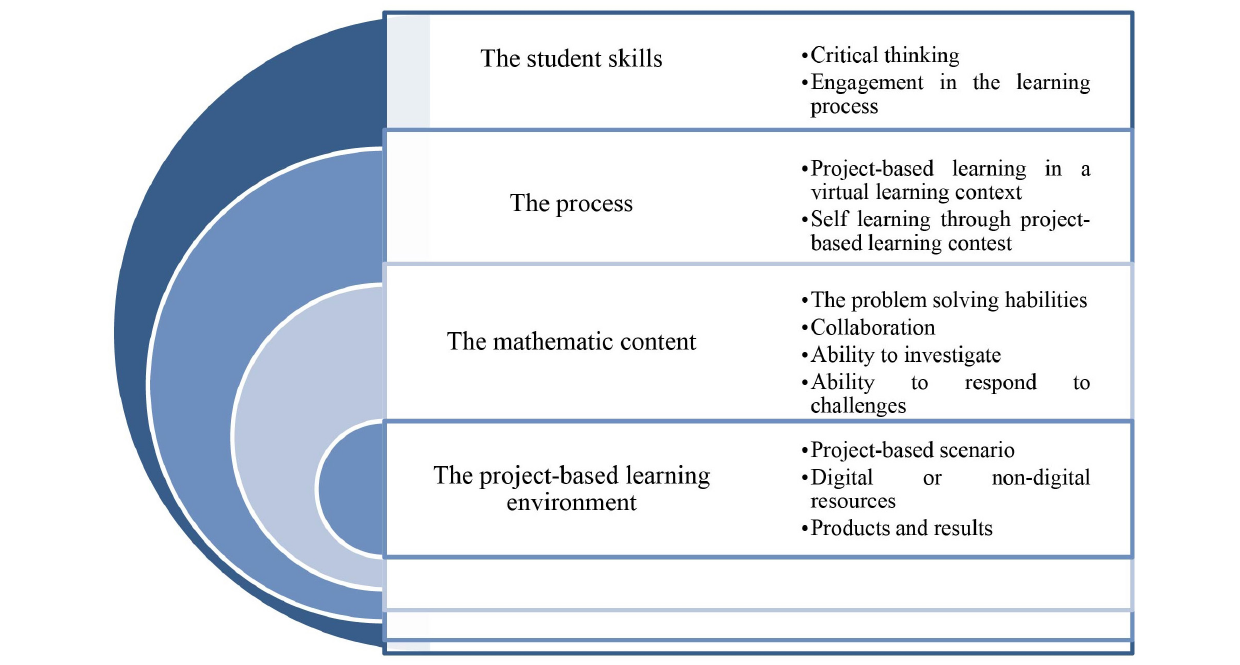
FIGURE 2 | Framework on regarding mathematical skills in teaching through a PBL. Authors’ own